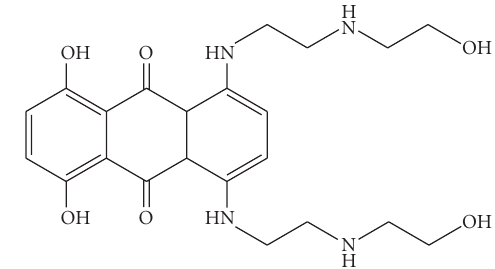
Figure 1: Structure of mitoxantrone